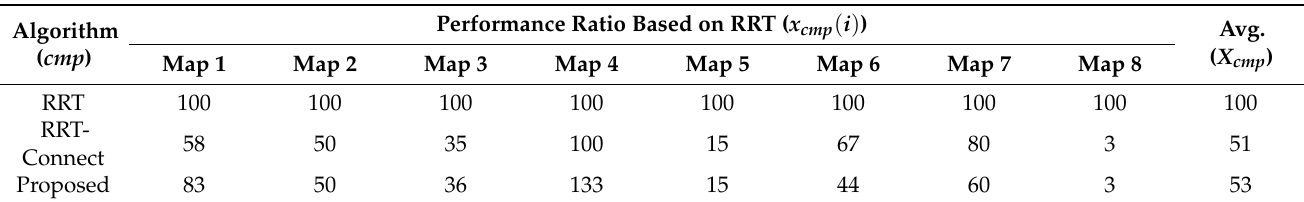
Table 12. Experimental results in total for the average planning time